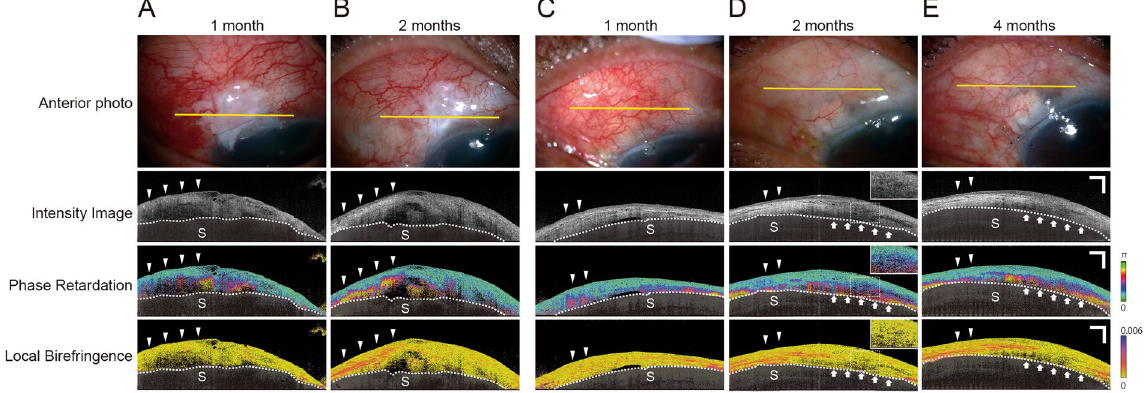
Figure 3. Representative cases in which phase retardation imaging detects early fibrotic changes in the bleb. ( A , B ) A 60-year-old man, 1 and 2 months after trabeculectomy ( A and B , respectively, had intraocular pressures (IOPs) of 13 and 16 mmHg, respectively, without hypotensive medications. Most of the bleb shows low birefringence on a local birefringence image at 1 month ( A ), whereas there is an apparent increase in phase retardation on the phase retardation image ( A , arrowheads). This area shows strong fibrotic changes on both phase retardation and local birefringence images at 2 months after surgery ( B , arrowheads). ( C – E ) A 69-year- old man at 1 month ( C ), 2 months ( D ), and 4 months ( E ) after trabeculectomy. IOPs were 12 mmHg (1 month) and 17 mmHg (2 months) without hypotensive medications and 14 mmHg (4 months) with hypotensive medications. At 1 month after surgery, the intensity image shows mild hyperreflectivity. There is a mild increase in phase retardation and a slight diffuse change of birefringence. The area with the mildly increased phase retardation at 1 month shows strong fibrotic changes at 2 months after surgery ( C and D , arrowheads). Arrows indicate the area of hyporeflectivity on the intensity image, as well as apparently increased phase retardation and low birefringence at 2 months after surgery ( D , arrows). That area shows apparent degeneration of fibrotic change at 4 months after surgery ( E , arrows). Sclera was covered with a semitransparent black shadow. The white dotted line delineates the boundary between the conjunctiva and sclera. Scale Bars, 1